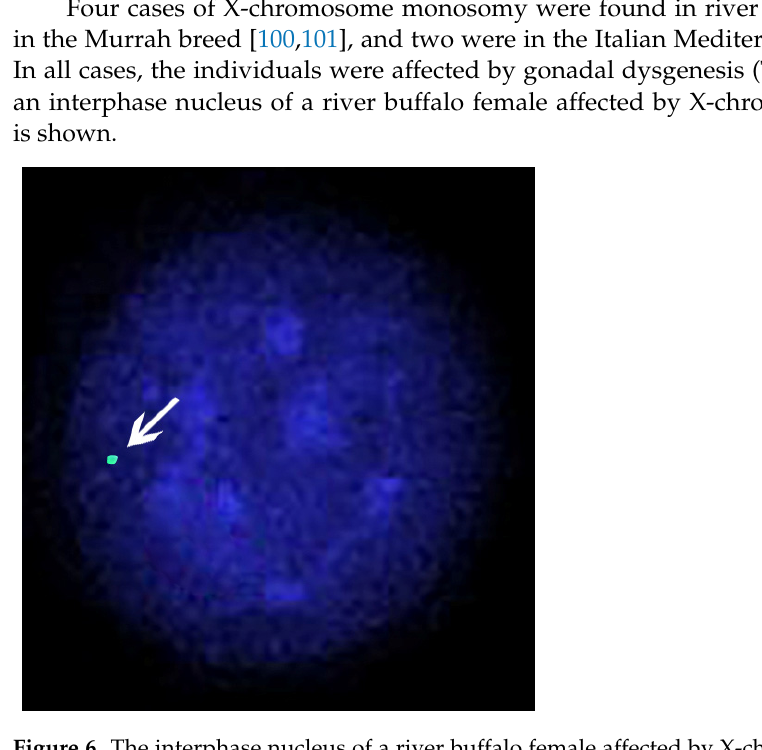
Figure 6. The interphase nucleus of a river buffalo female affected by X-chromosome monosomy, and showing only one FITC signal (arrow) after FISH mapping with a specific marker (PGK) of the X chromosome.